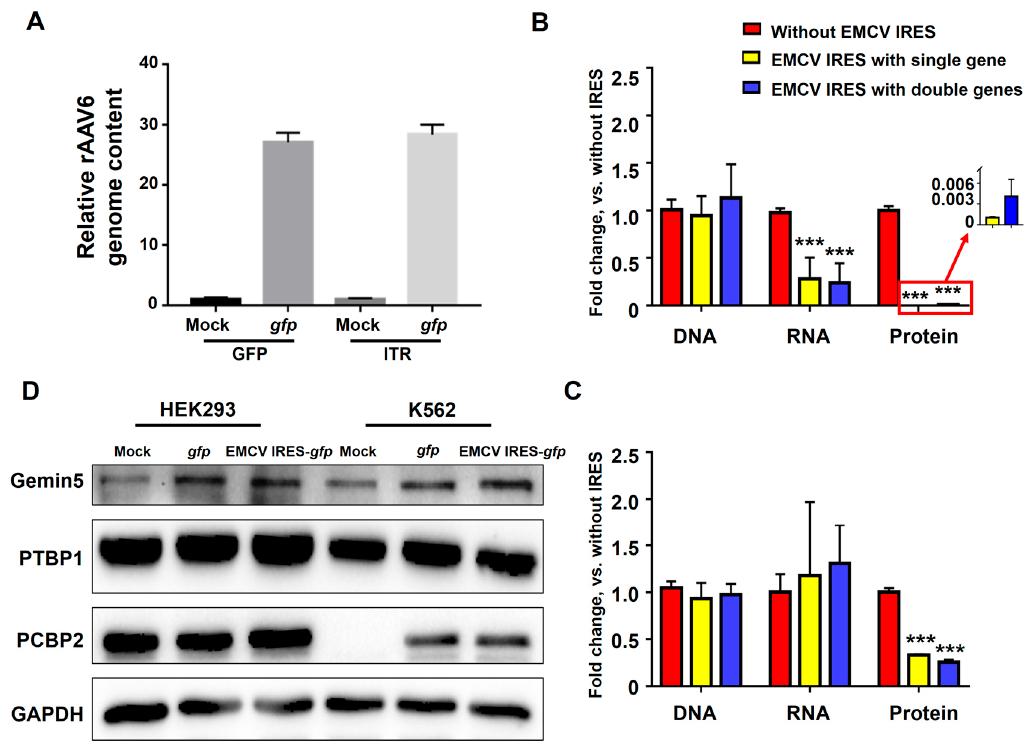
Figure 5. EMCV IRES inhibited the expression of transgene on the translational level. (A) HEK293 cells were transduced with rAAV6-CMVp- gfp at 10,000 vgs/cell. The relative rAAV6 genome content was detected by qPCR using GFP primers and ITR primers. (B) K562 and (C) HEK293 cells were transduced with rAAV6-CMVp- gfp and rAAV6-CMVp-EMCV IRES- gfp at 10,000 vgs/cell. Total DNA and RNA were isolated at 4 days post-transduction for qPCR. Transgene expression was detected by fluorescence microscopy at 72 hours post-transduction. (D) Western blot of total cell extracts (lysate) from HEK293 cells and K562 cells after rAAV6-CMVp- gfp or rAAV6-CMVp-EMCV IRES- gfp infection for Gemin5, PTBP1, and PCBP2 expression.